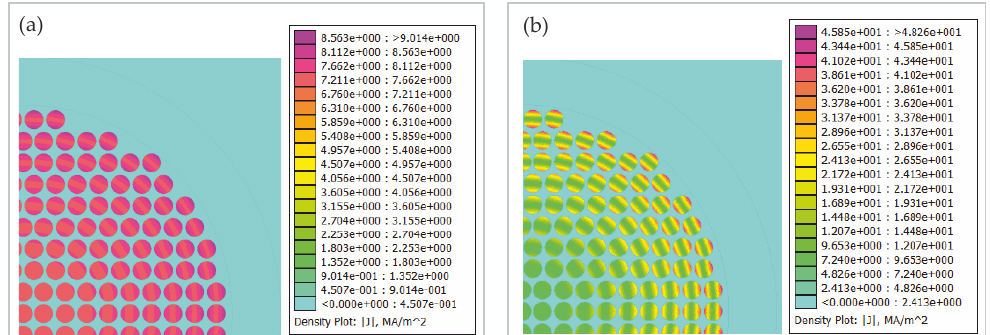
Figure 3. Current density in the cable at 20 ◦ C and at a frequency of 5 kHz ( a ) and 50 kHz ( b ). The AC equivalent resistance of the cable is evaluated in the post-processing phase based on the overall losses occurring in the conductor volume and the square of the current: